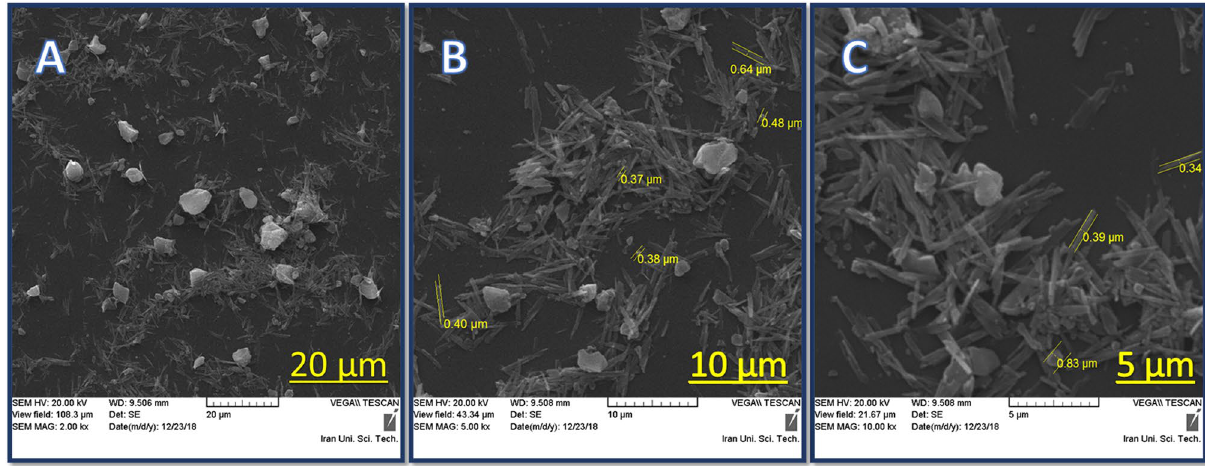
Figure 3. SEM images of Cu@MCM-41-HPr-Met catalyst.